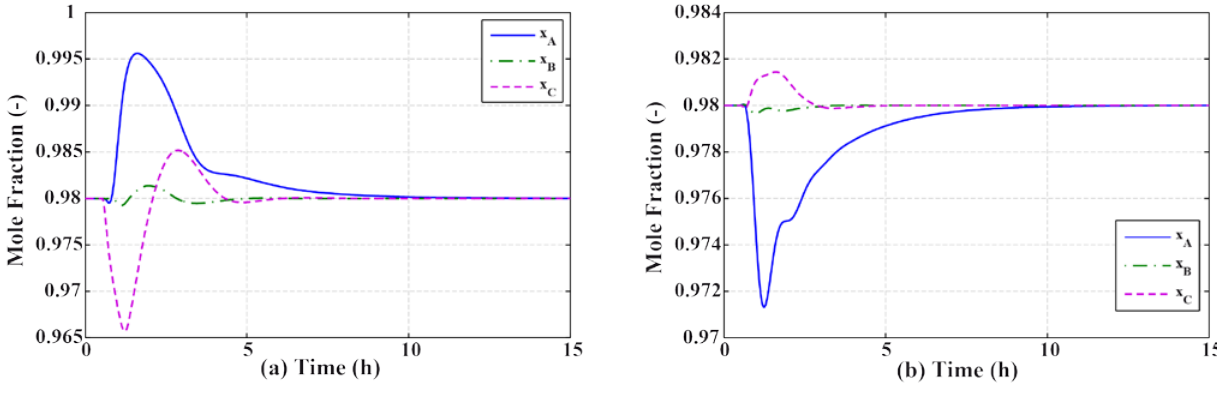
in the feed composition. 𝑥 𝐴